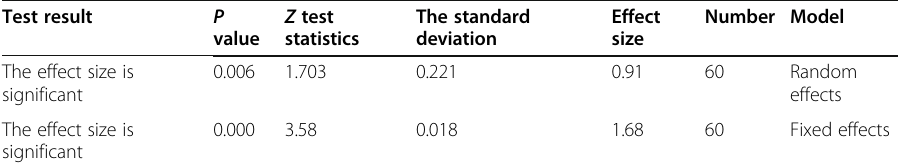
Table 7 Total effect size results